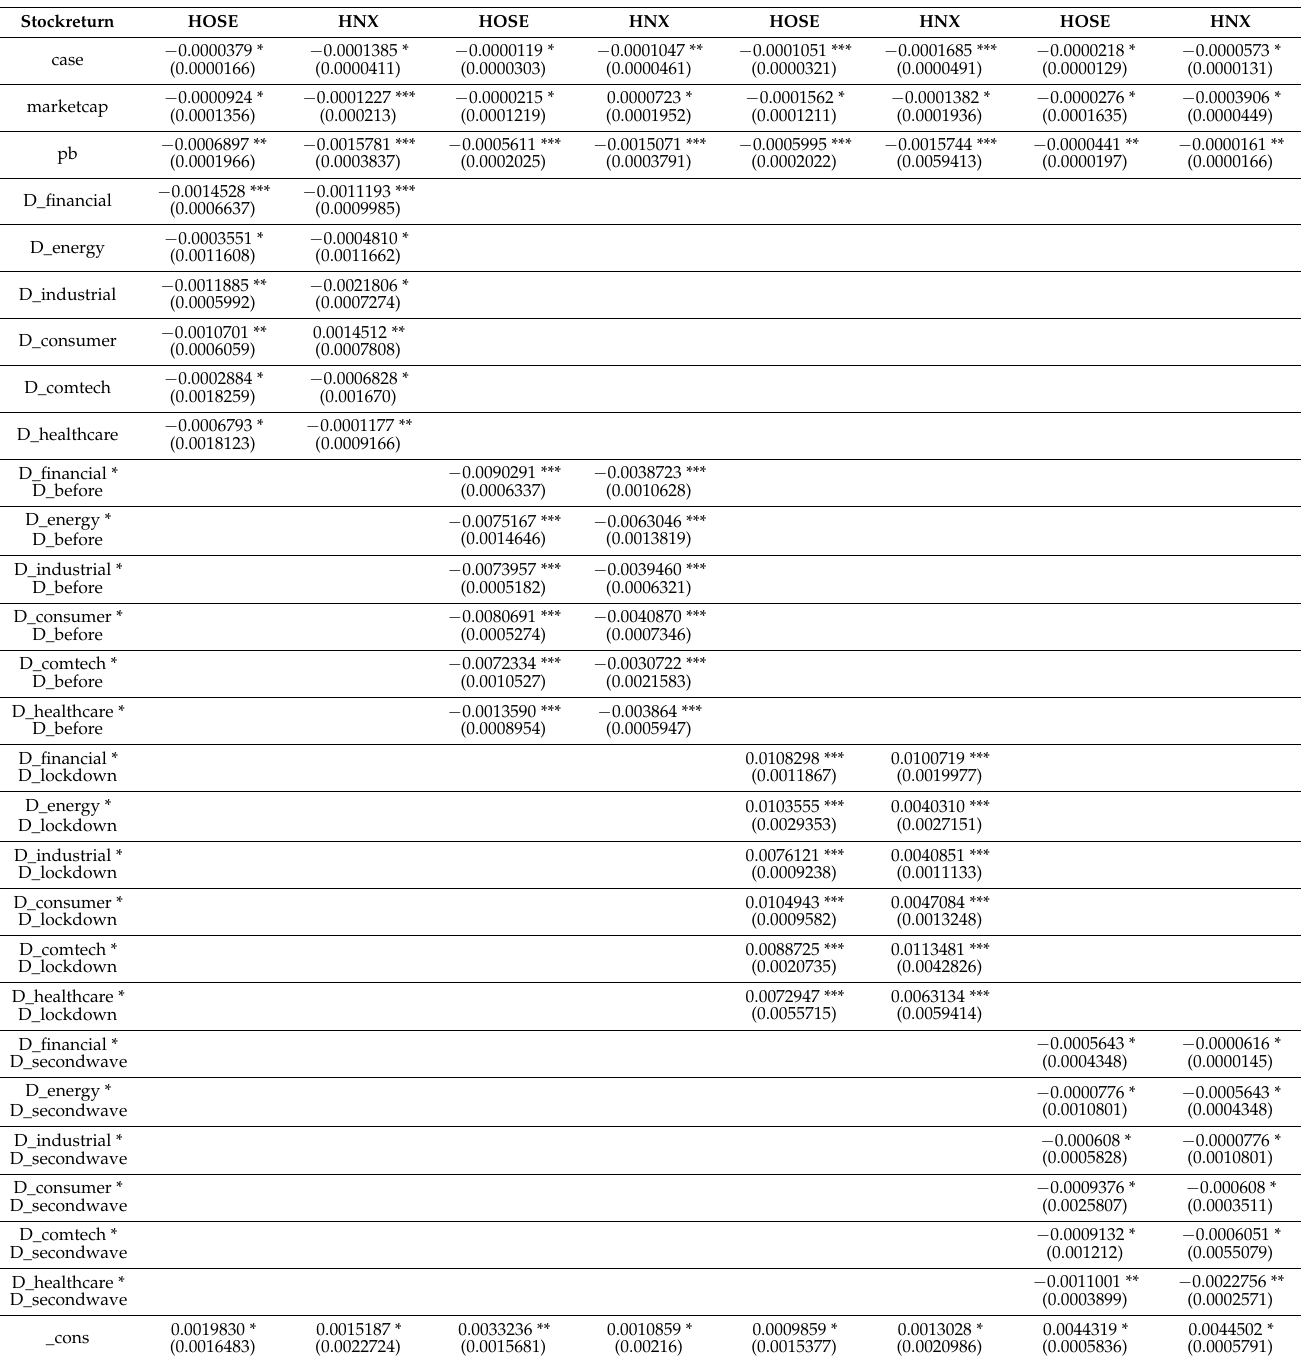
Table 6. The relationships between stock returns and various industries during pre-lockdown, lockdown, and second-wave